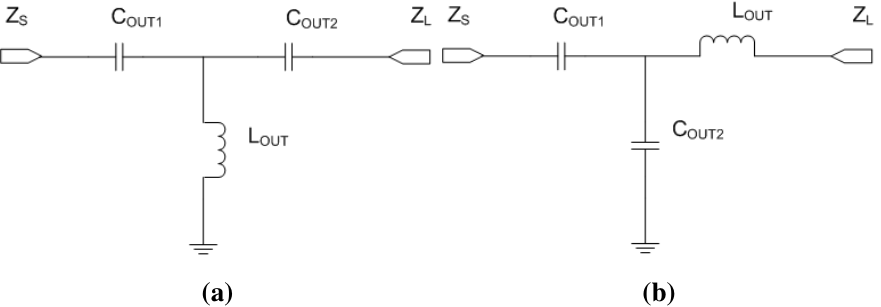
Figure 21. Two possible input matching networks.